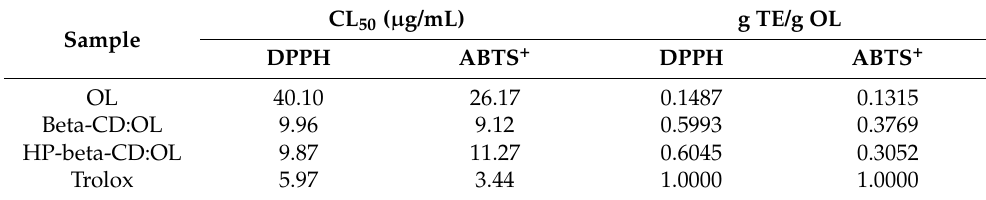
Table 5. CL 50 of OL, beta-CD:OL and HP-beta-CD:OL against DPPH and ABTS +